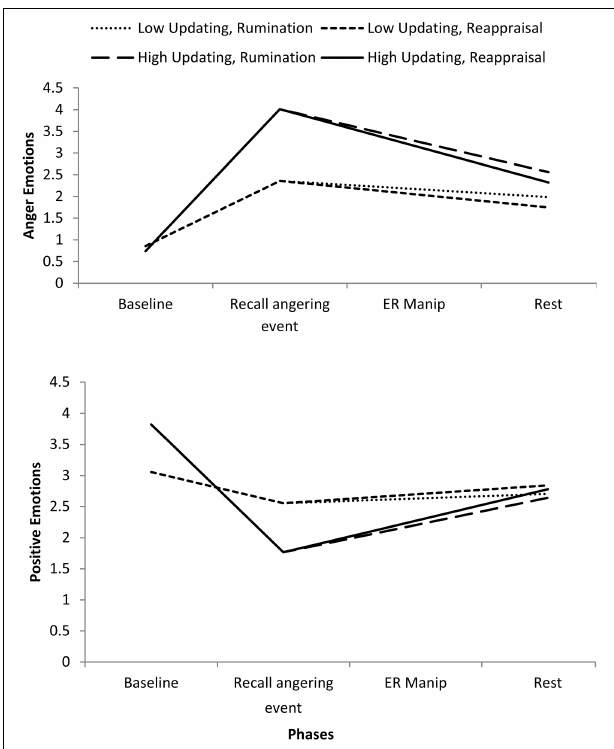
FIGURE 2 | Anger and positive emotions in Study 2 during the different phases of the anger recall task. Low and high updating represent participants who scored 2SD below and above the sample average emotional updating ability,